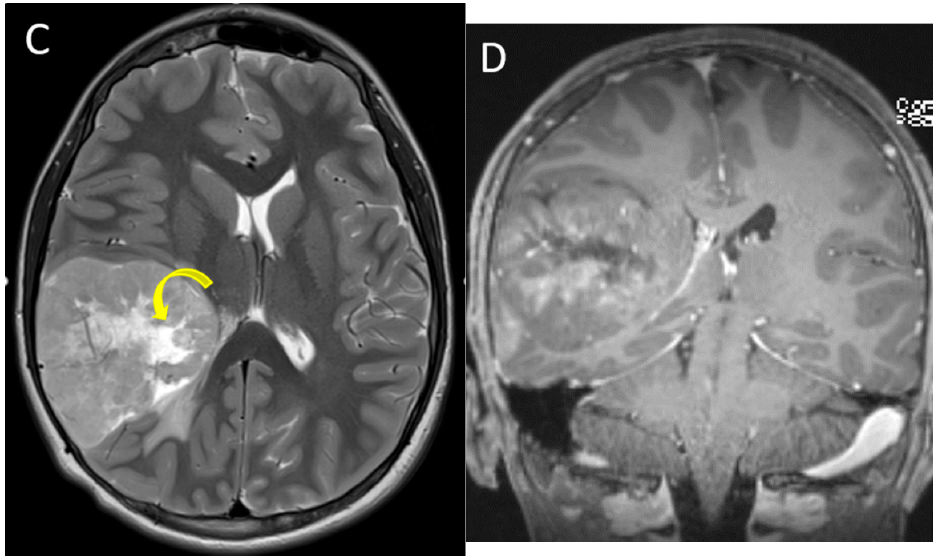
Figure 7. A 14-year-old male with H3 G34R mutant high-grade glioma. Axial DWI ( A ), axial SWI ( B ), axial T2 ( C ) and coronal post-contrast T1-weighted ( D ) images demonstrate a large mass in the right parieto-temporal lobes, with diffusion restriction of the solid portions, central areas of blood products and/or mineralization (arrow), isointense T2 signal with central necrosis (curved arrow), and heterogenous post-contrast enhancement.